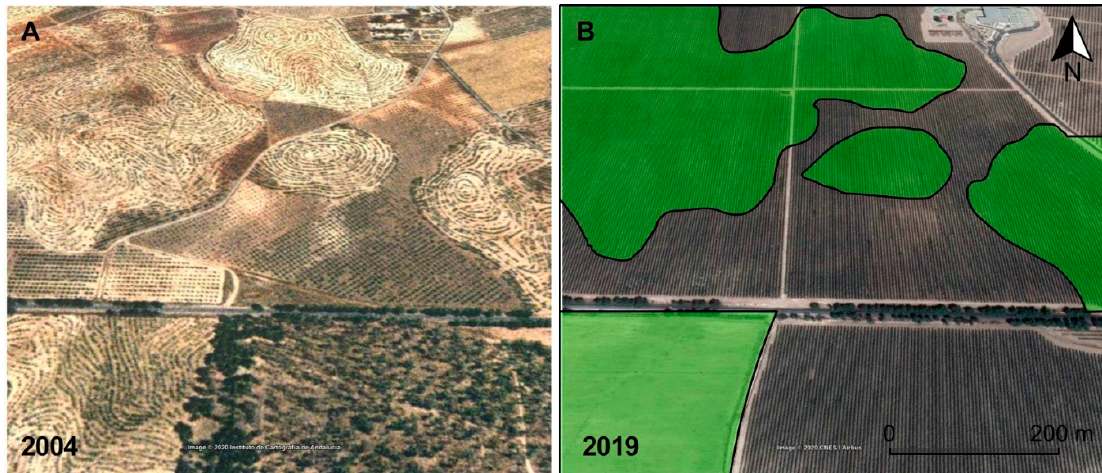
Figure 4. ( A ) Reforestation with pine trees, following the contours of the small reliefs, and irrigation olive orchards in the study area (2004). ( B ) The same area in 2019, where afforestations have been dismantled and the territory has been levelled (green areas) to facilitate the planting super intensive irrigated olive groves. Map data: Google, DigitalGlobe.